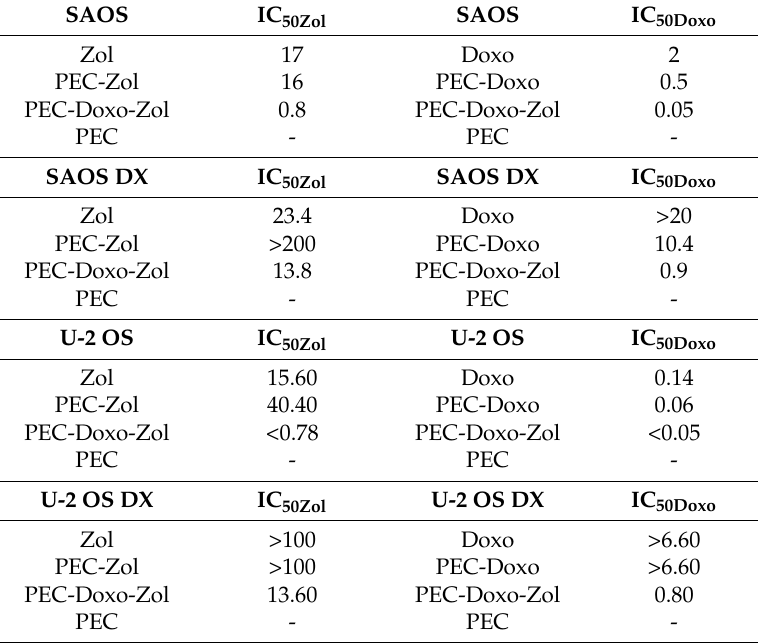
Table 6. IC 50 (M) of all developed formulations on wild-type and Doxo-resistant SAOS and U-2 OS, after 72 h of treatment.